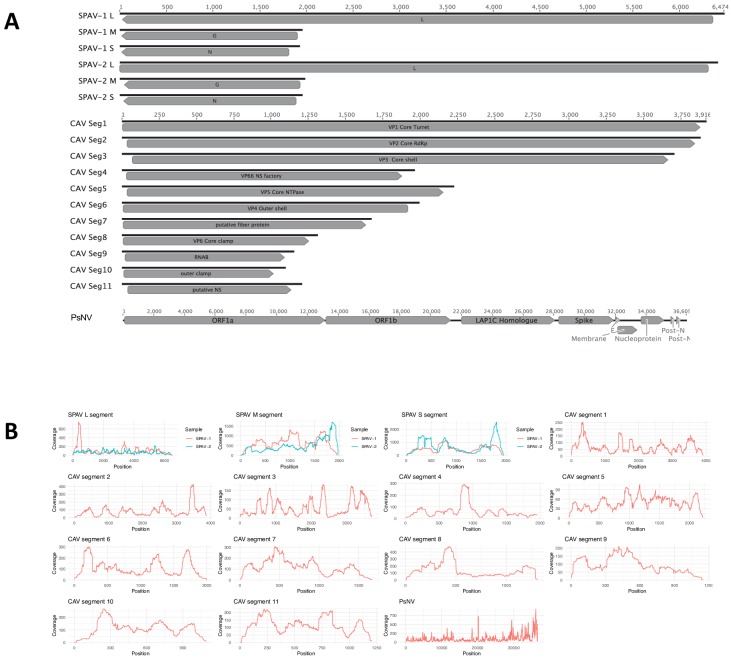
Genome organisation and coverage.(A) Genome organisation, ORF prediction and (B) Genome coverage for Salmon pescarenavirus 1 and 2 (SPAV), Chinook Aquareovirus (CAV) segments 1-and Pacific salmon Nidovirus (PsNV). Black lines represent the genome and boxes show the predicted open reading frames. Nucleotide sequences are provided in fasta format in the source data for Figure 1.10.7554/eLife.47615.005Figure 1—figure supplement 1—source data 1.Viral genomic nucleotide sequences.